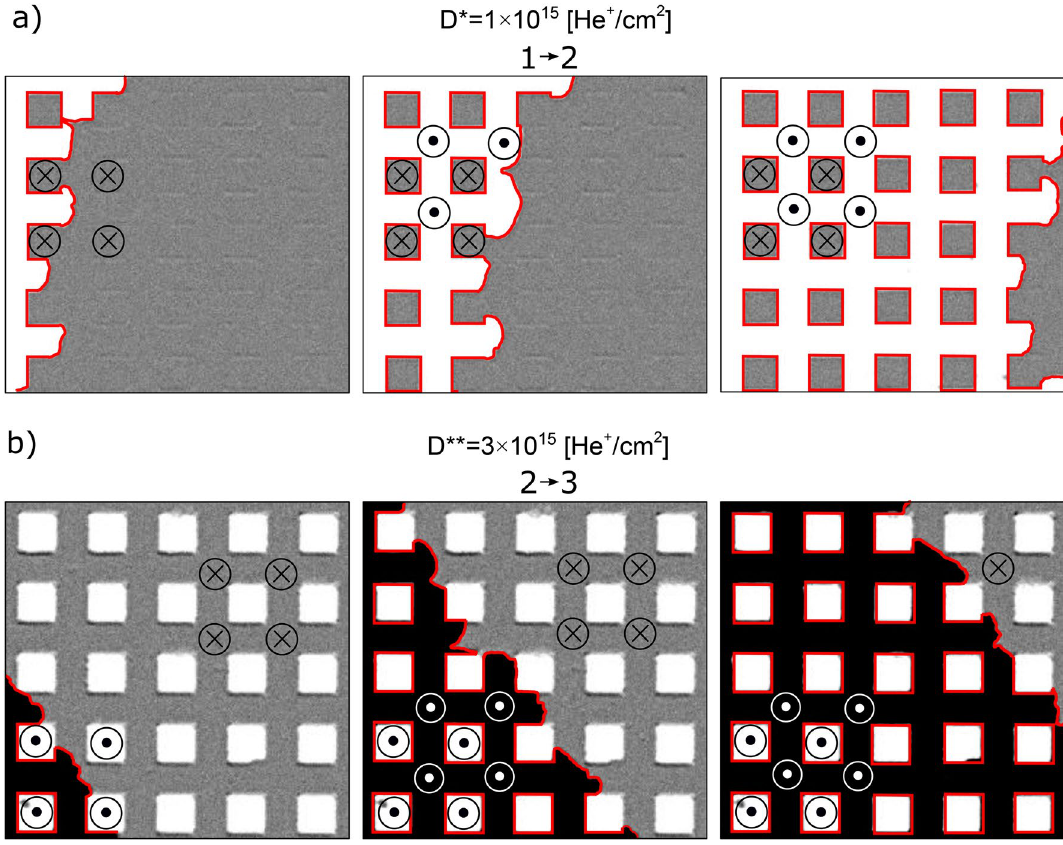
Figure 6. Snapshots of DW propagation during the matrix reversal for the system with a = 25 μm (sample B2) magnetically patterned with two different ion doses.